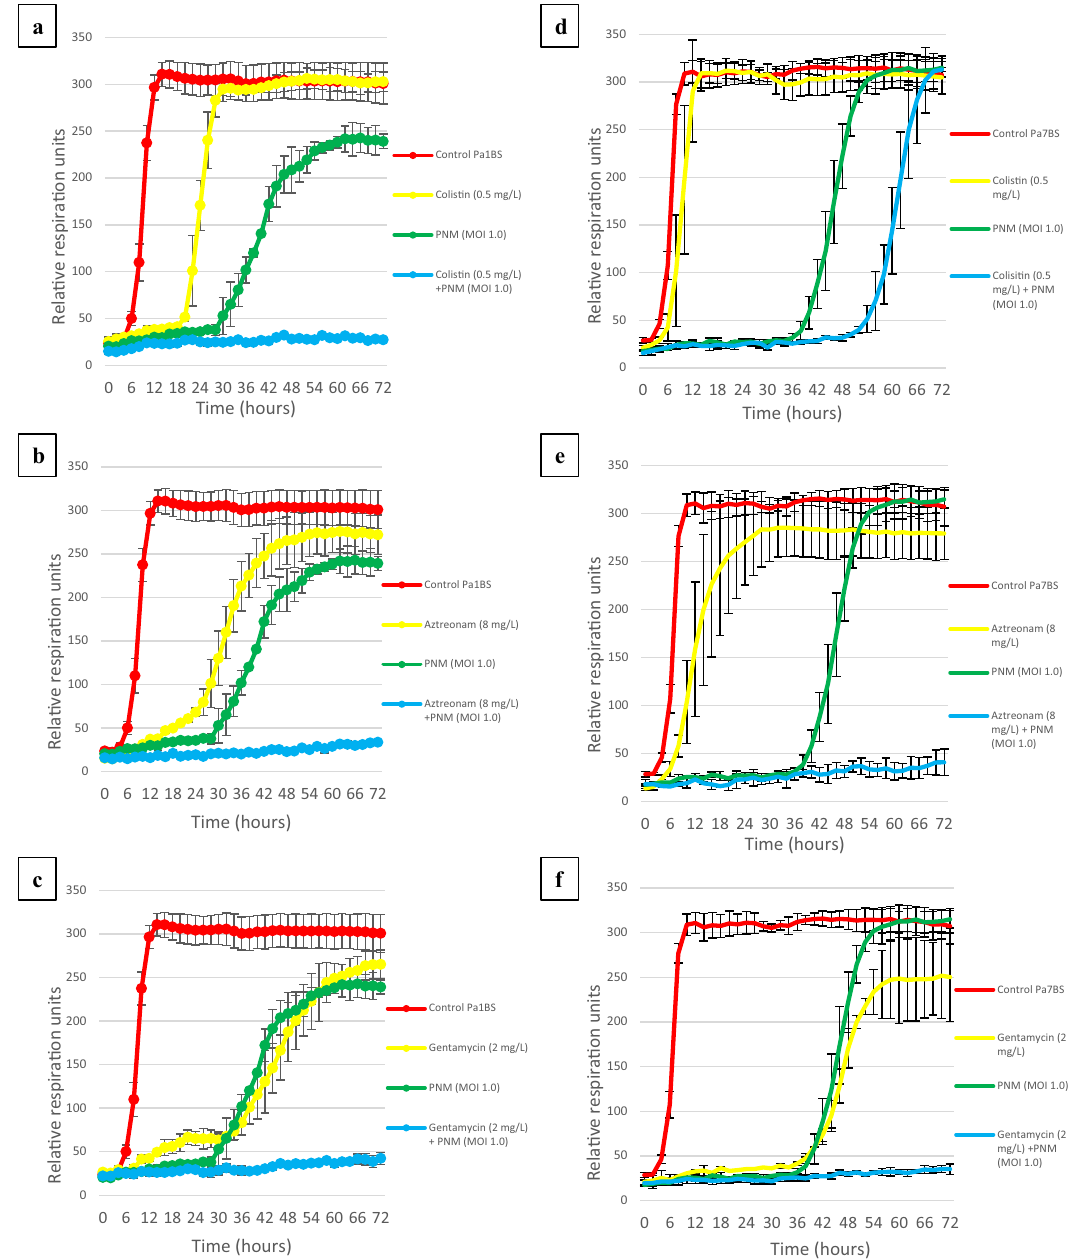
Fig. 4 | Phage-antibiotic synergy assay results. Activities of phage PNM (at mul- tiplicityof infection[MOI] 1.0)and a / d colistin(0.5mg/L), b / e aztreonam(8mg/L), and c / f gentamycin (2mg/L), as well as combinations of phage PNM and these antibioticsagainst Pseudomonasaeruginosa isolatePa1 BS ( a – c )andPa7 BS ( d – f )were determined using an OmniLog® system. Bacterial proliferation is presented